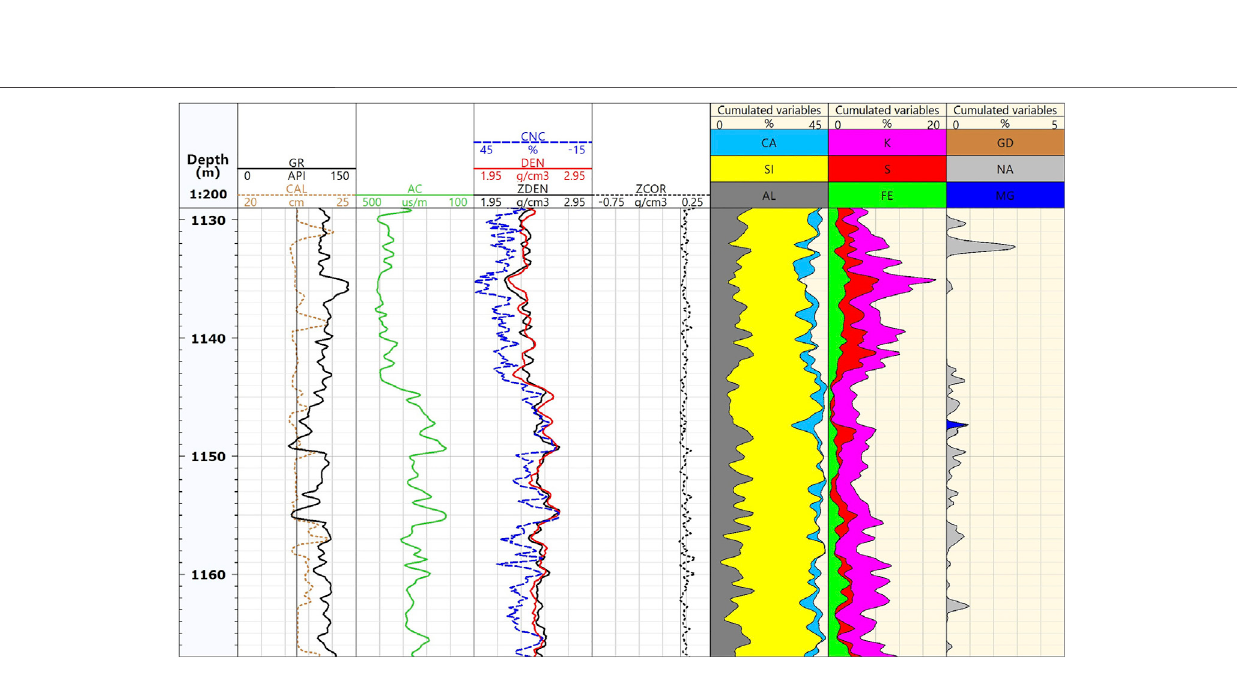
Frontiers in Earth Science |